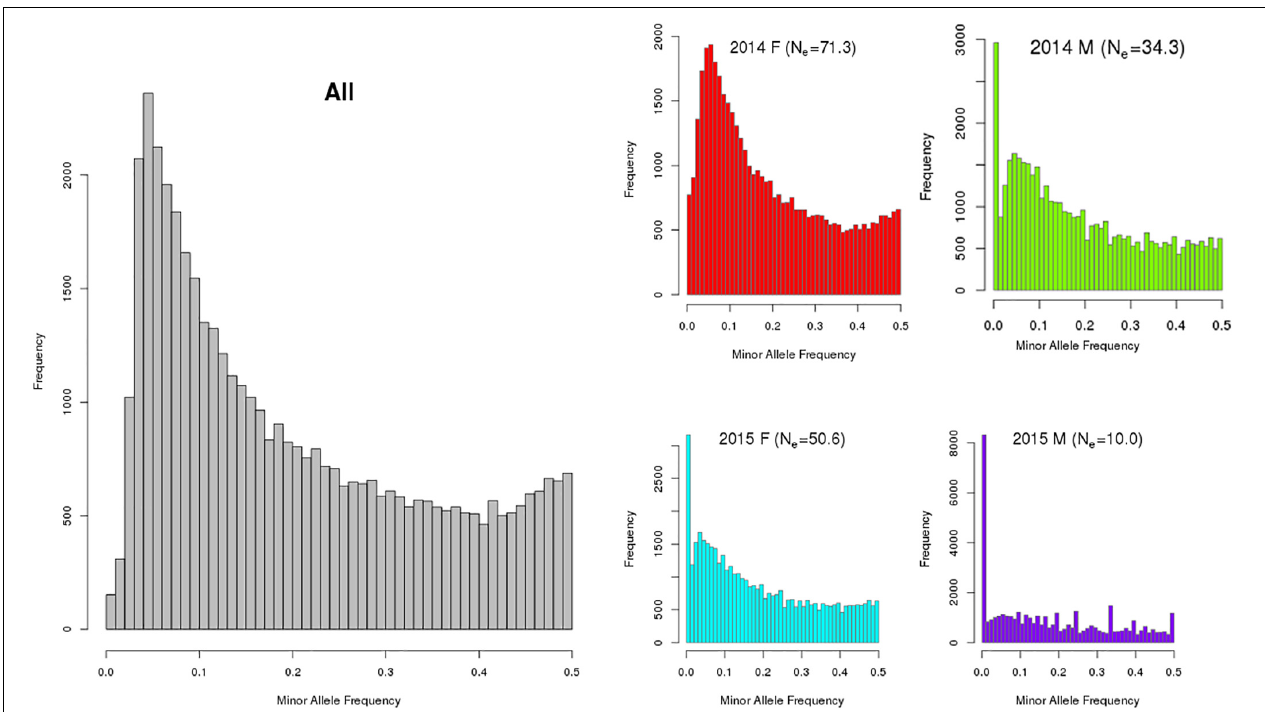
FIGURE 1 | Minor allele frequency distribution of combined (All) and by year class [2014 and 2015; females (F) and males (M) for (king salmon the value in brackets in the individual graph title is the estimated Ne)]. Note: The y -axis scale varies between these plots and a MAF of zero indicates a SNP is detected in at least one of the 4 groups but not present (i.e., had only one allele) in the specific group being analyzed. The number of SNPs (MAF > 0) observed were 46,007 and 43,838 for the 2014 female ( n = 220) and male ( n = 55) year class, respectively, and 44,114, and 38,323 for 2015 female ( n = 159) and male ( n = 35) year class, respectively. Note that only a small sub-set of the 2015 year class males had been sampled at the time this analysis was completed and were included for comparison.